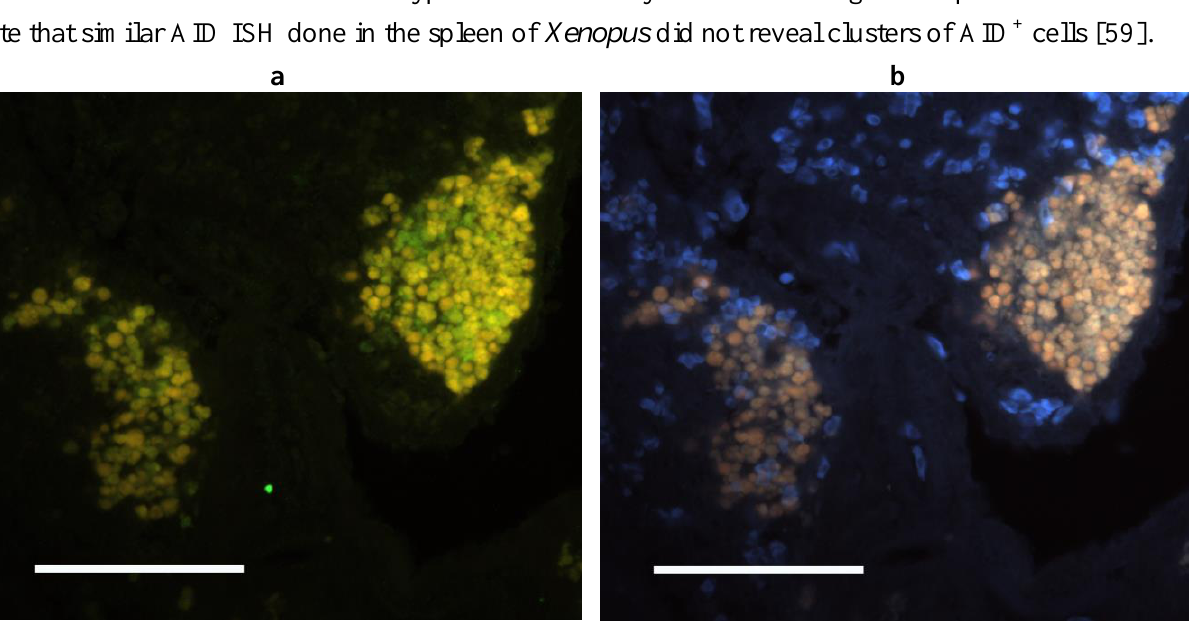
Figure 2. AID expressing cells in channel catfish spleen. ( a ) In situ hybridization with AID anti-sense probe (green) under excitation for FITC. Melanomacrophages autofluoresce yellow; ( b ) UV excitation elicits orange/brown autofluorescence of only melanomacrophages (and RBCs in blue). Methods are as described in